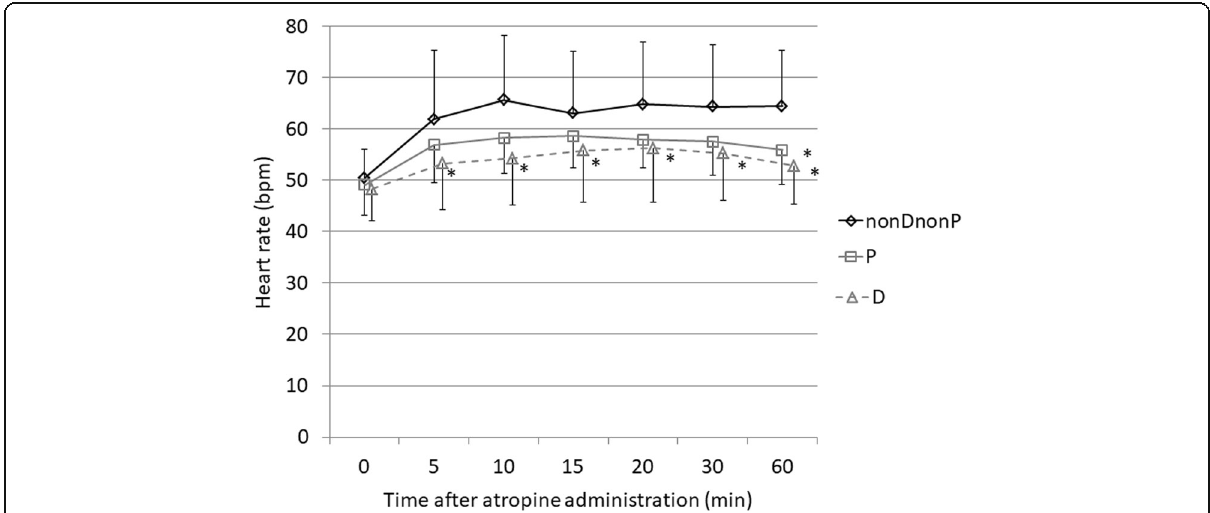
Fig. 1 Heart rate after administration of atropine in the dexmedetomidine, propofol, and non-dexmedetomidine-non-propofol groups. Values are expressed as the mean ± SD. * p < 0.025 (compared with the nonDnonP group). D, dexmedetomidine; nonDnonP, non dexmedetomidine-non propofol; P, propofol; SD, standard